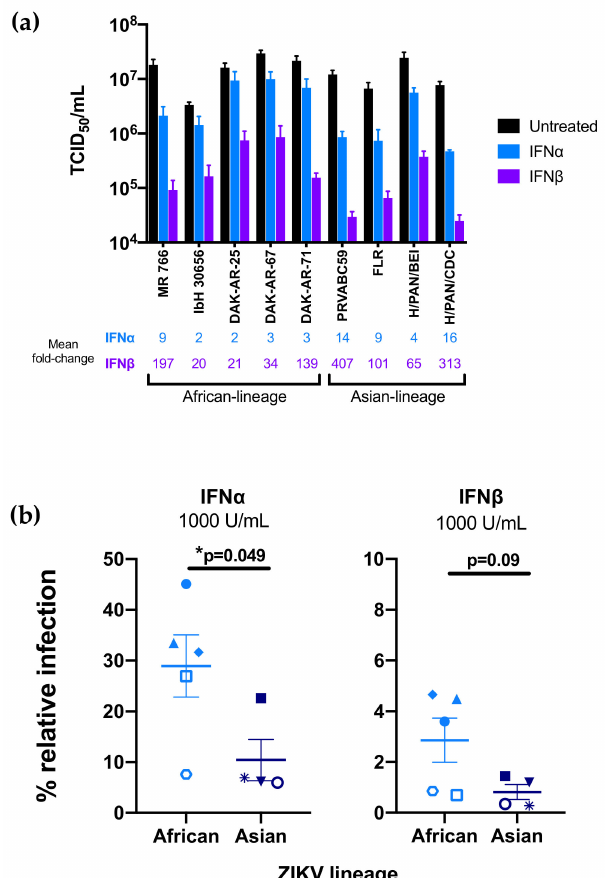
Figure 2. E ff ect of type-I interferon (IFN-I) pretreatment on diverse Zika virus strains in A549 cells. ( a ) The susceptibility of each ZIKV strain to restriction by IFN α -2a or IFN β was assessed in A549 cells. Cells were treated with 1000 U / mL IFN α -2a or IFN β 24 h prior to infection as well as following infection with each ZIKV strain. The titer (TCID50 / mL) of each strain 48 h post-infection in the absence of IFN-I (black), presence of IFN α -2a (blue), and presence of IFN β (purple) is shown. All data represent the average of at least four independent experiments that were carried out with two independently generated stocks of each ZIKV strain. Error bars represent SEM. The mean fold-reduction in viral replication of each ZIKV strain by pretreatment with IFN α and IFN β is listed below the graph. ( b ) Comparison of IFN α -2a-mediated (1000 U / mL) and IFN β -mediated restriction (1000 U / mL) of African-lineage vs. Asian-lineage ZIKV strains. Percent relative infection (IFN +/ IFN-) is plotted for African-lineage (light blue) and Asian-lineage (dark blue) ZIKV strains. Error bars indicate SEM. A two-tailed Student’s t -test was used to compare percent relative infection of African-lineage vs. Asian-lineage ZIKV strains for each IFN condition (* p =